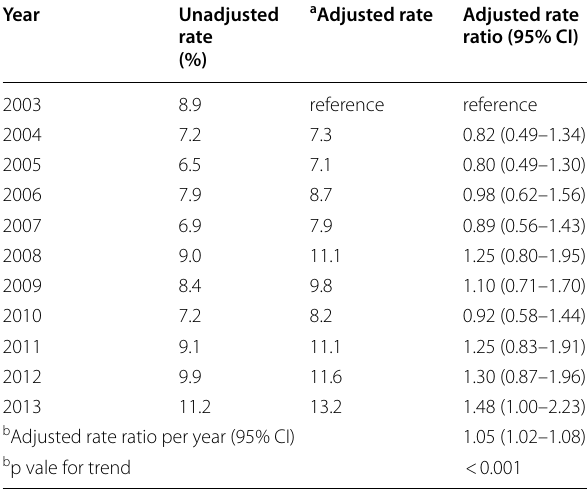
The model was adjusted for the age, gender, household income, and regions. There were no interactions a Model-adjusted rates of survival to discharge for each year were obtained by multiplying the observed rate for the reference year (2003) by the corresponding rate ratios from a model evaluating the year as a categorical variable b Adjusted rate ratio per year and p-value for trend were calculated with a model evaluating the year as a continuous variable. CI: confidence